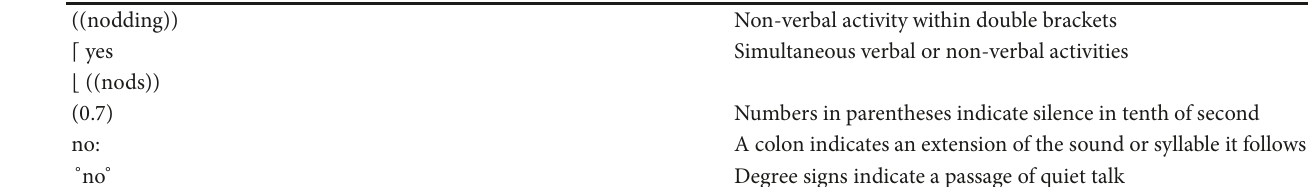
Table 2: Key to transcription